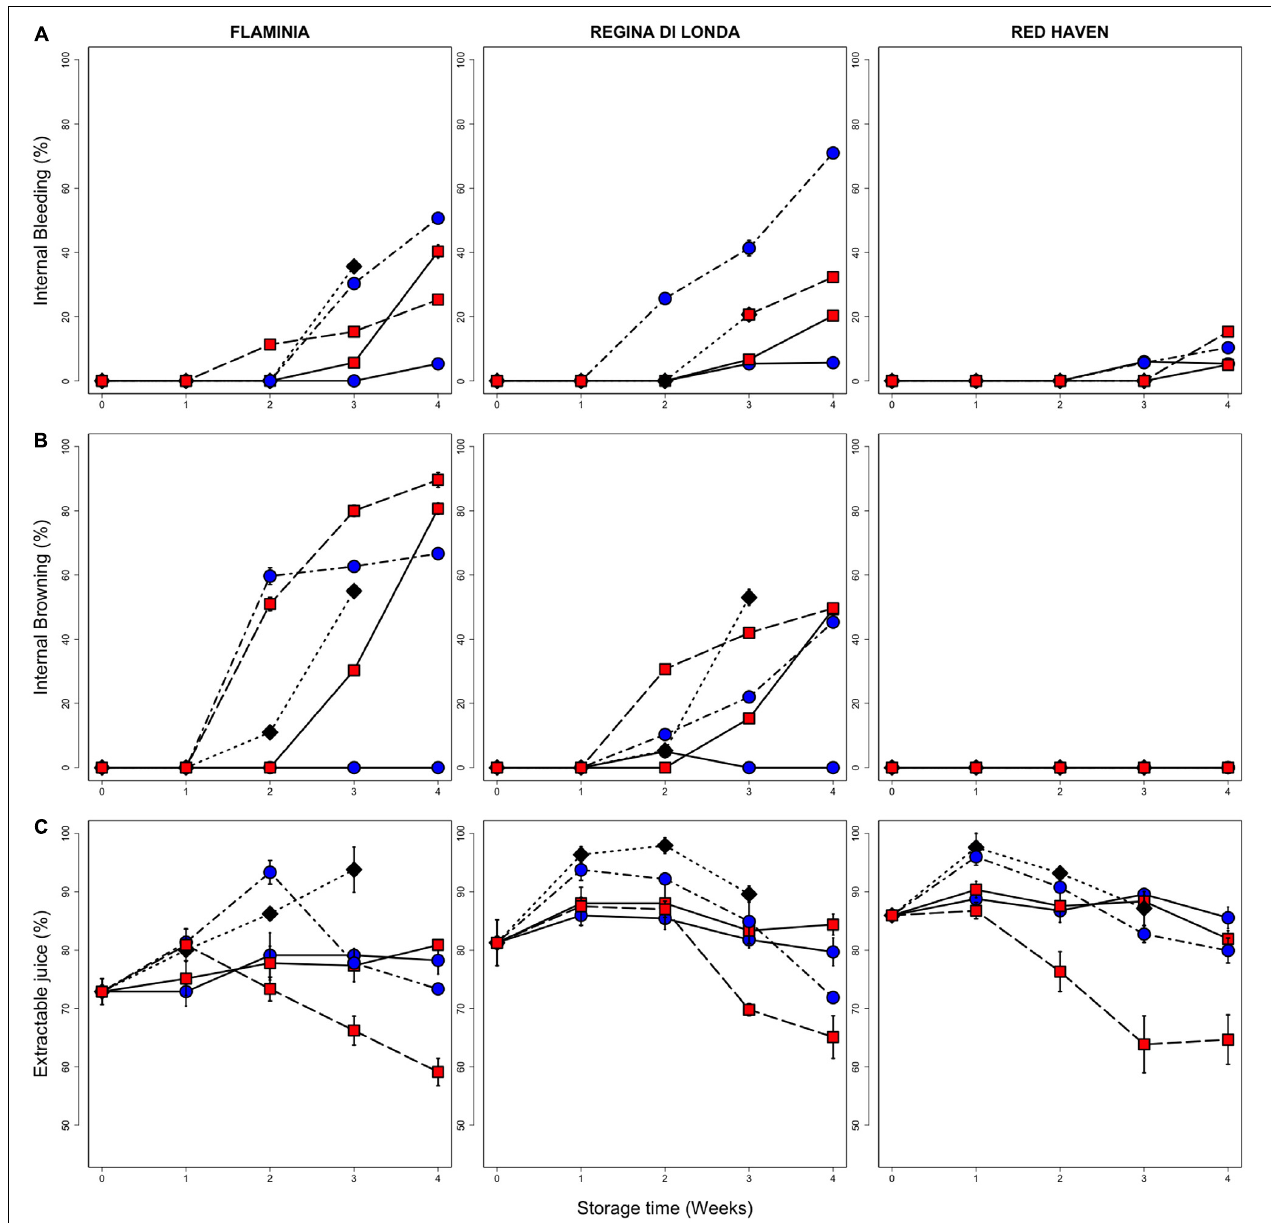
FIGURE 2 | Incidence of CIs (flesh bleeding, A ; flesh browning, B ; and loss of juiceness, C ) in the three peach fruit varieties. All measurements have been performed on fruit stored up to three (control, 20 ◦ C) or four (0.5 and 5.5 ◦ C) weeks and then kept for three additional days under shelf-life conditions (20 ◦ C, SL; dotted lines), and on peaches sampled immediately after cold storage (no SL; solid lines). Values are the mean of nine (browning and bleeding) and three (loss of juiciness) biological replicates and bars represent SE. Black diamonds, blue circles and red squares represent control fruit, 0.5 and 5.5 ◦ C stored peaches, respectively.